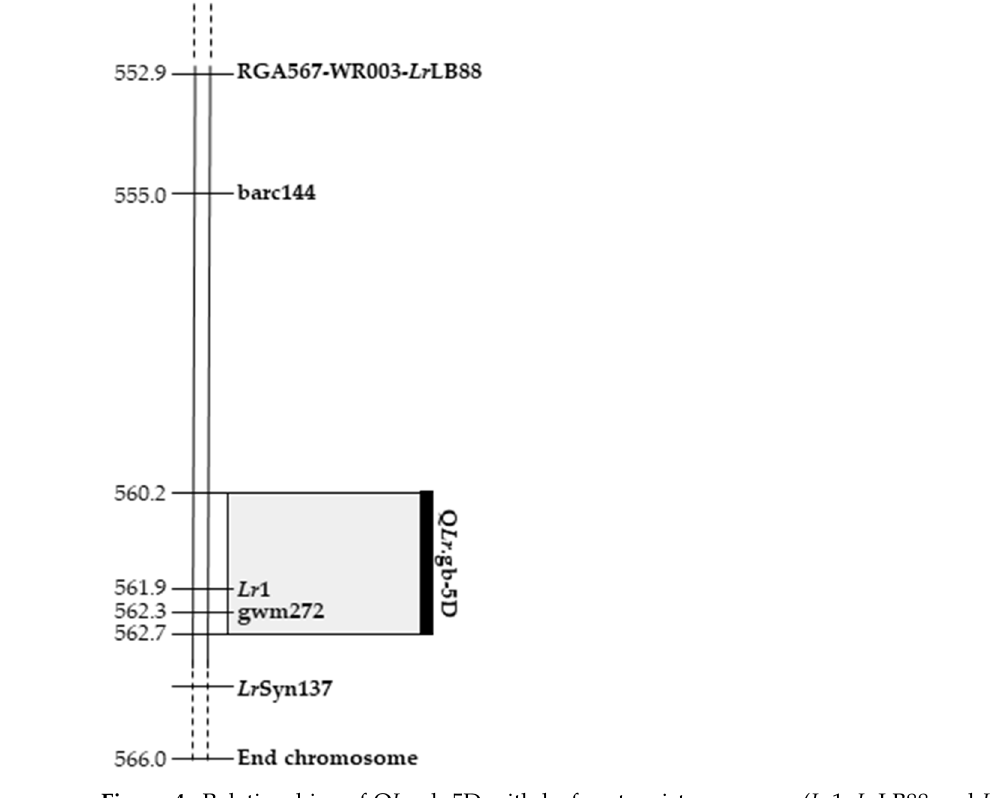
Figure 4. Relationships of Q Lr .gb-5D with leaf rust resistance genes ( Lr 1, Lr LB88 and Lr Syn137) previously mapped on chromosome 5DL. The physical position of molecular markers retrieved from the CS reference genome are reported.